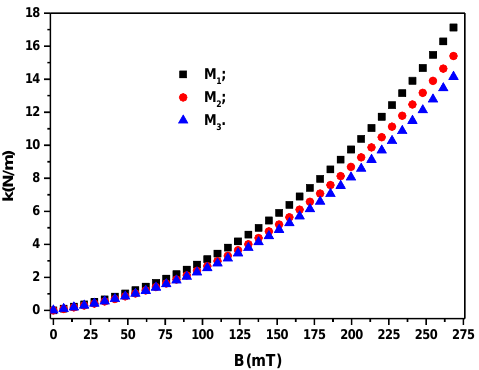
Figure 9. The magneto-deformation coupling constant, k , of the membranes M i ( i = 1,2,3 ) depending on the values of the magnetic flux density, B .